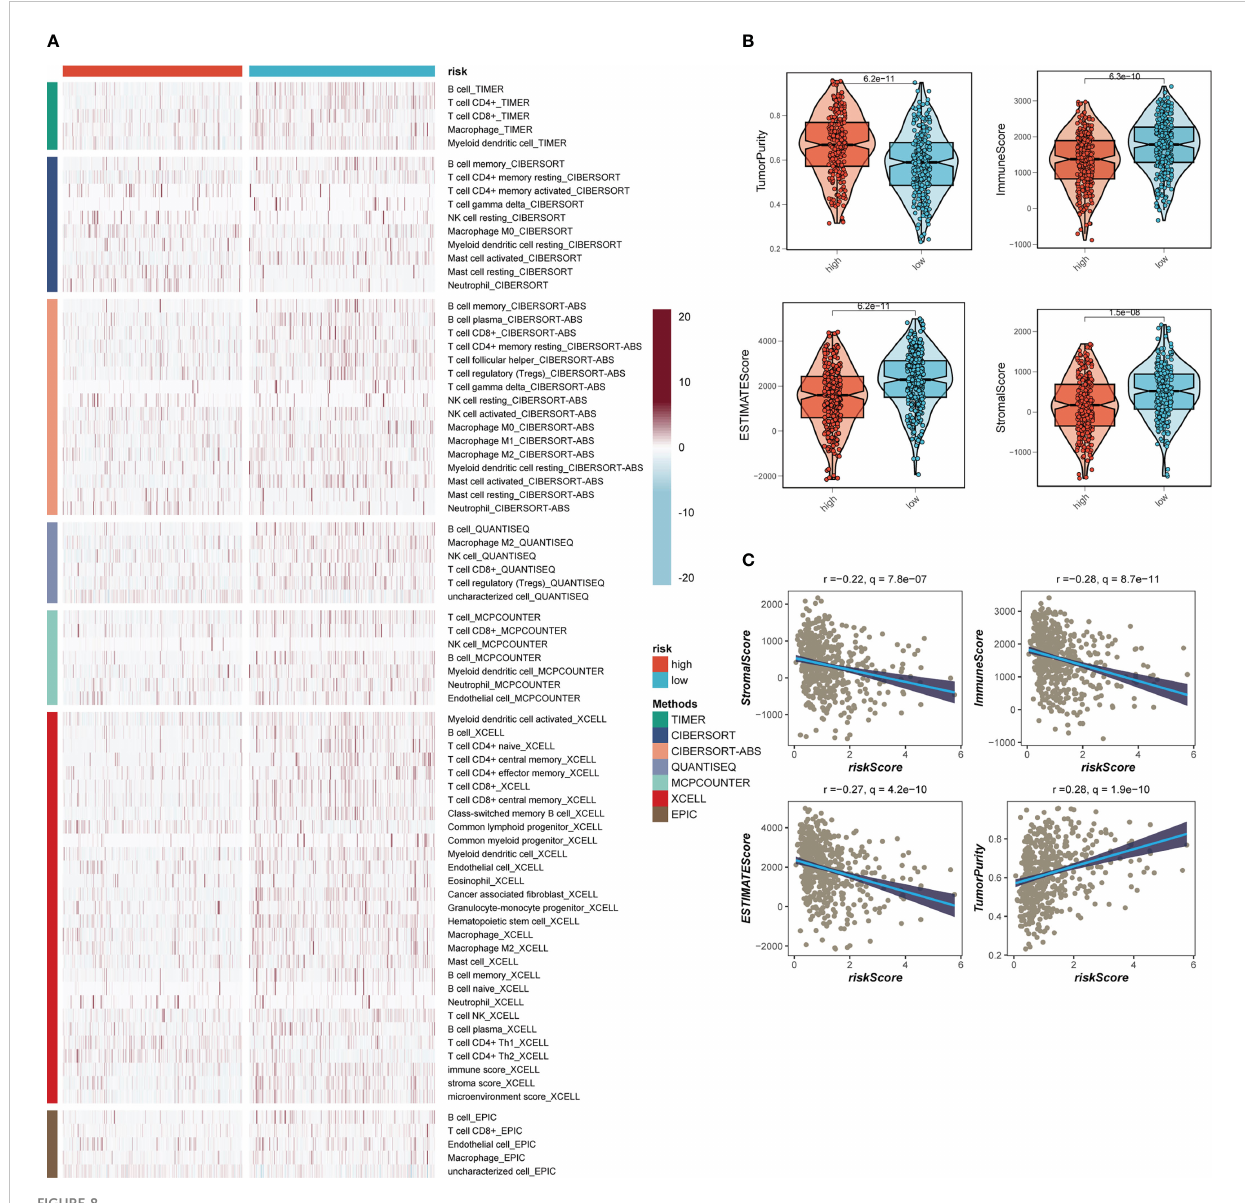
FIGURE 8 Analysis of immune in fi ltration. (A) Seven algorithms assess differences in immune in fi ltration status between different risk groups. (B) The violin plot demonstrated the difference in Stromal Score, Immune Score, ESTIMATE Score, and tumor purity calculated using the ESTIMATE algorithm between the two risk subgroups. (C) The correlations in Stromal Score, Immune Score, ESTIMATE Score, and tumor purity calculated using the ESTIMATE algorithm between the two risk